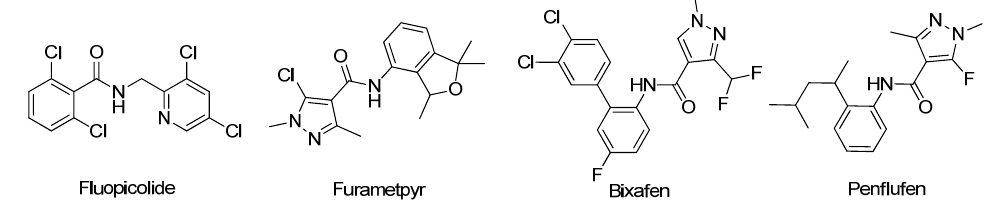
Figure 1. Chemical structures of Fluopicolide, Furametpyr, Bixafen and Penflufen.